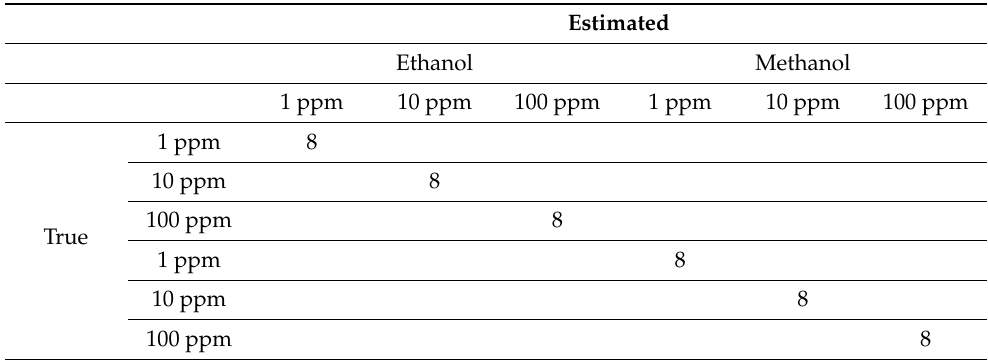
Table 1. Confusion matrix of the classification of the different types of measurements (type of gas and its concentration). Estimated Ethanol Methanol 1 ppm 10